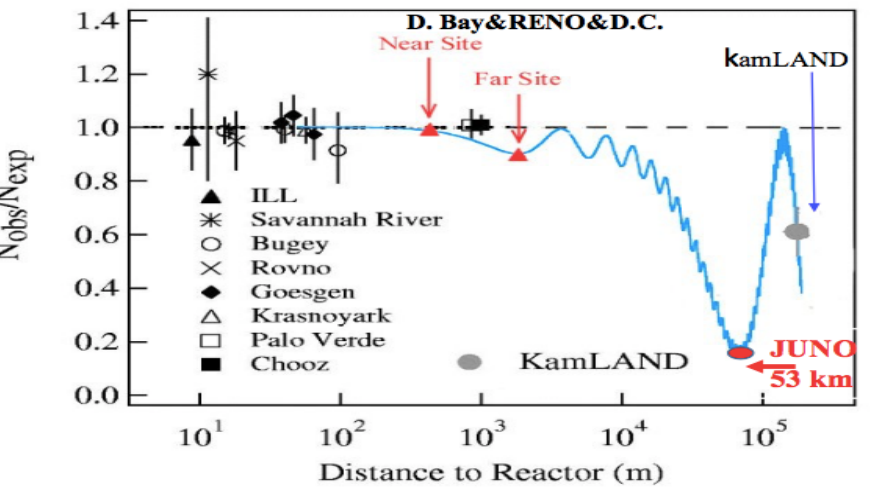
Figure 4. Representation of the ratio between the number of observed antineutrino events and the corresponding expected value in absence of oscillation, as a function of the baseline, for different past, present and future reactor experiments. One can notice, among the others, the results of the near and far detectors for Daya-Bay [43], Double CHOOZ [44] and RENO [45] and the ones of KamLAND and